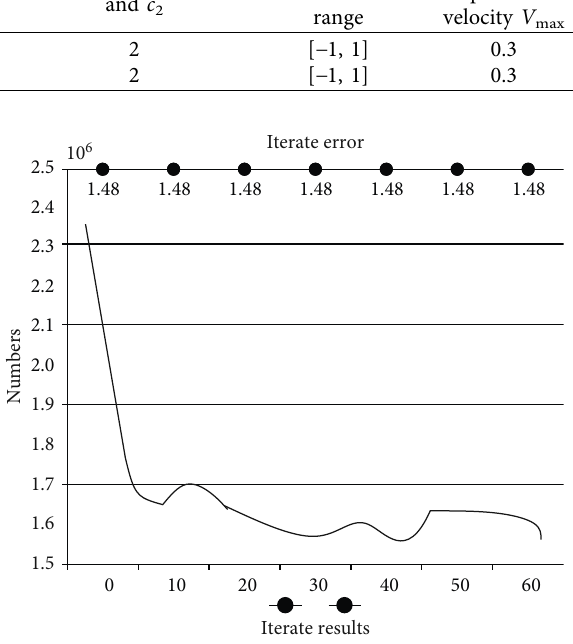
Figure 8: Iterative results of the PSO-ELM algorithm model (par-50). Figure 9: Iterative results of the PSO-ELM algorithm model (par-2).